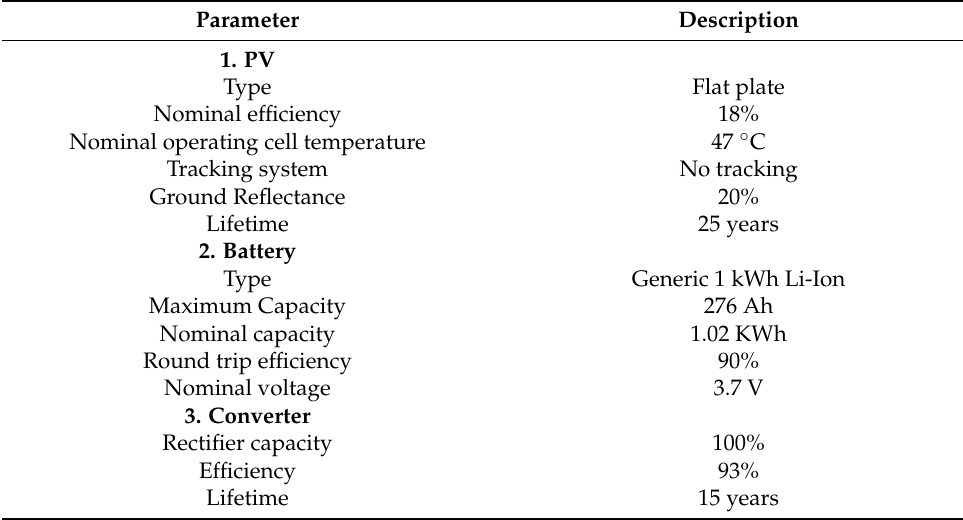
Table 2. Financial cost values of the